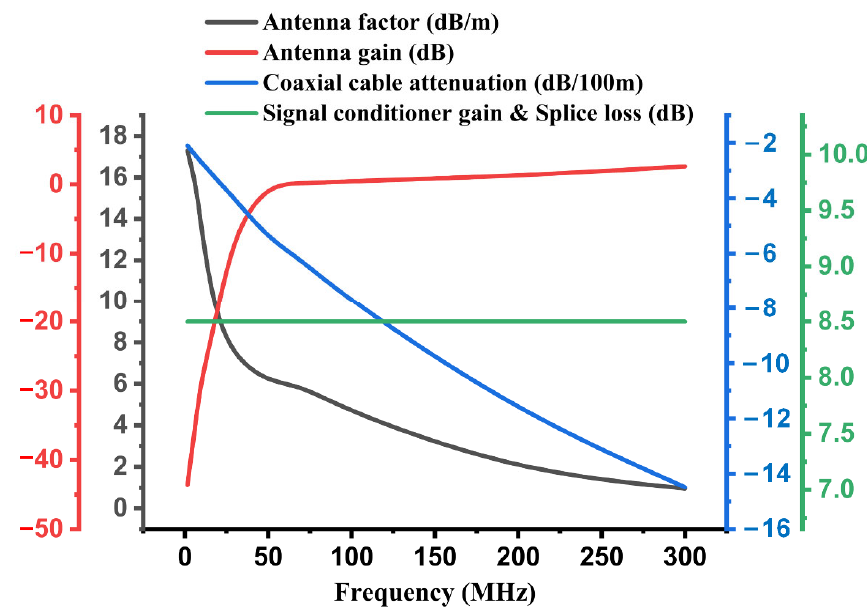
Figure 8. Experimental data correction parameters.